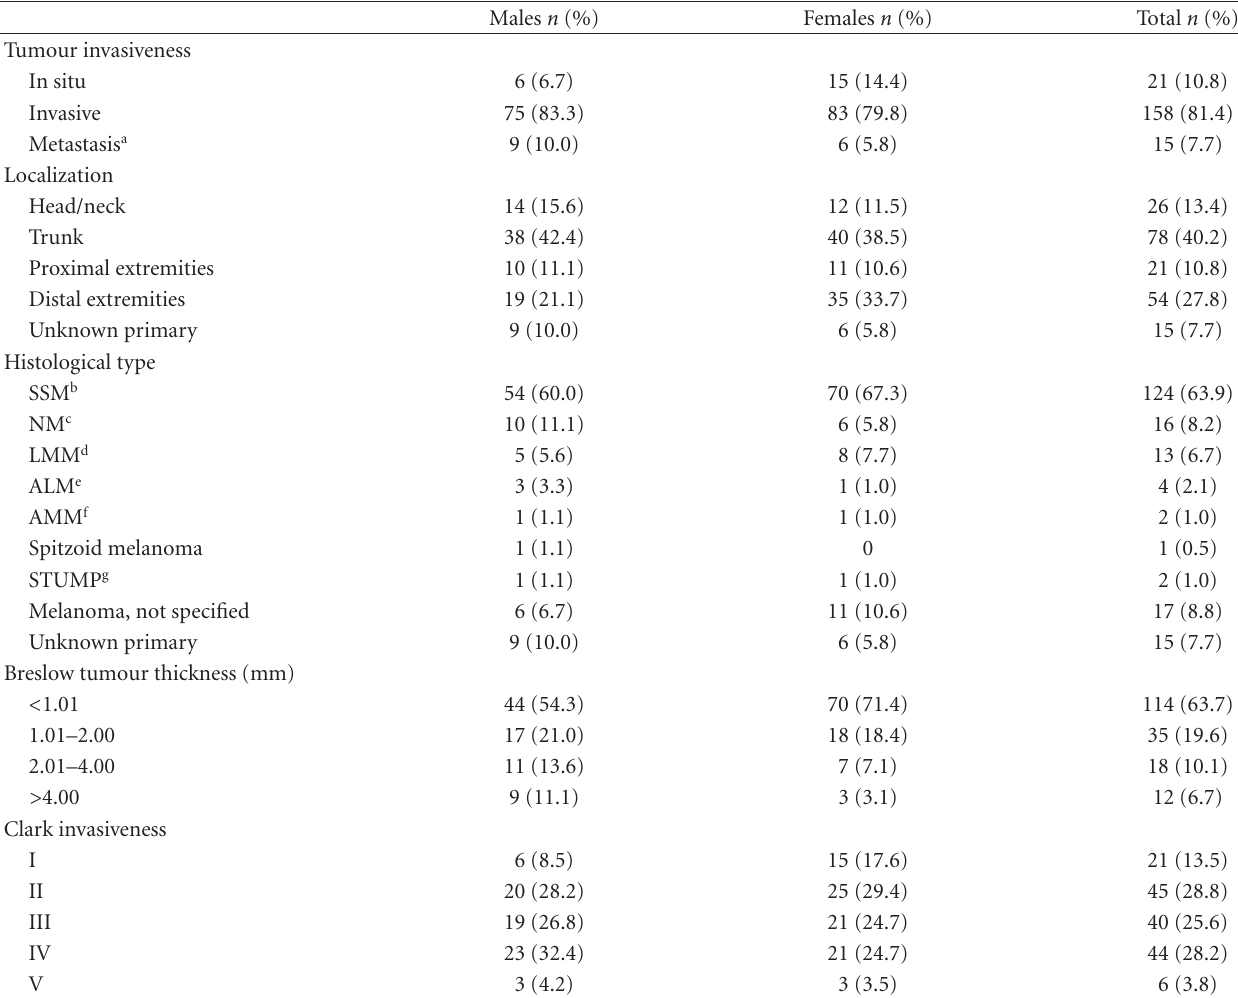
Table 1: Descriptive statistics for the first cutaneous melanoma (CM